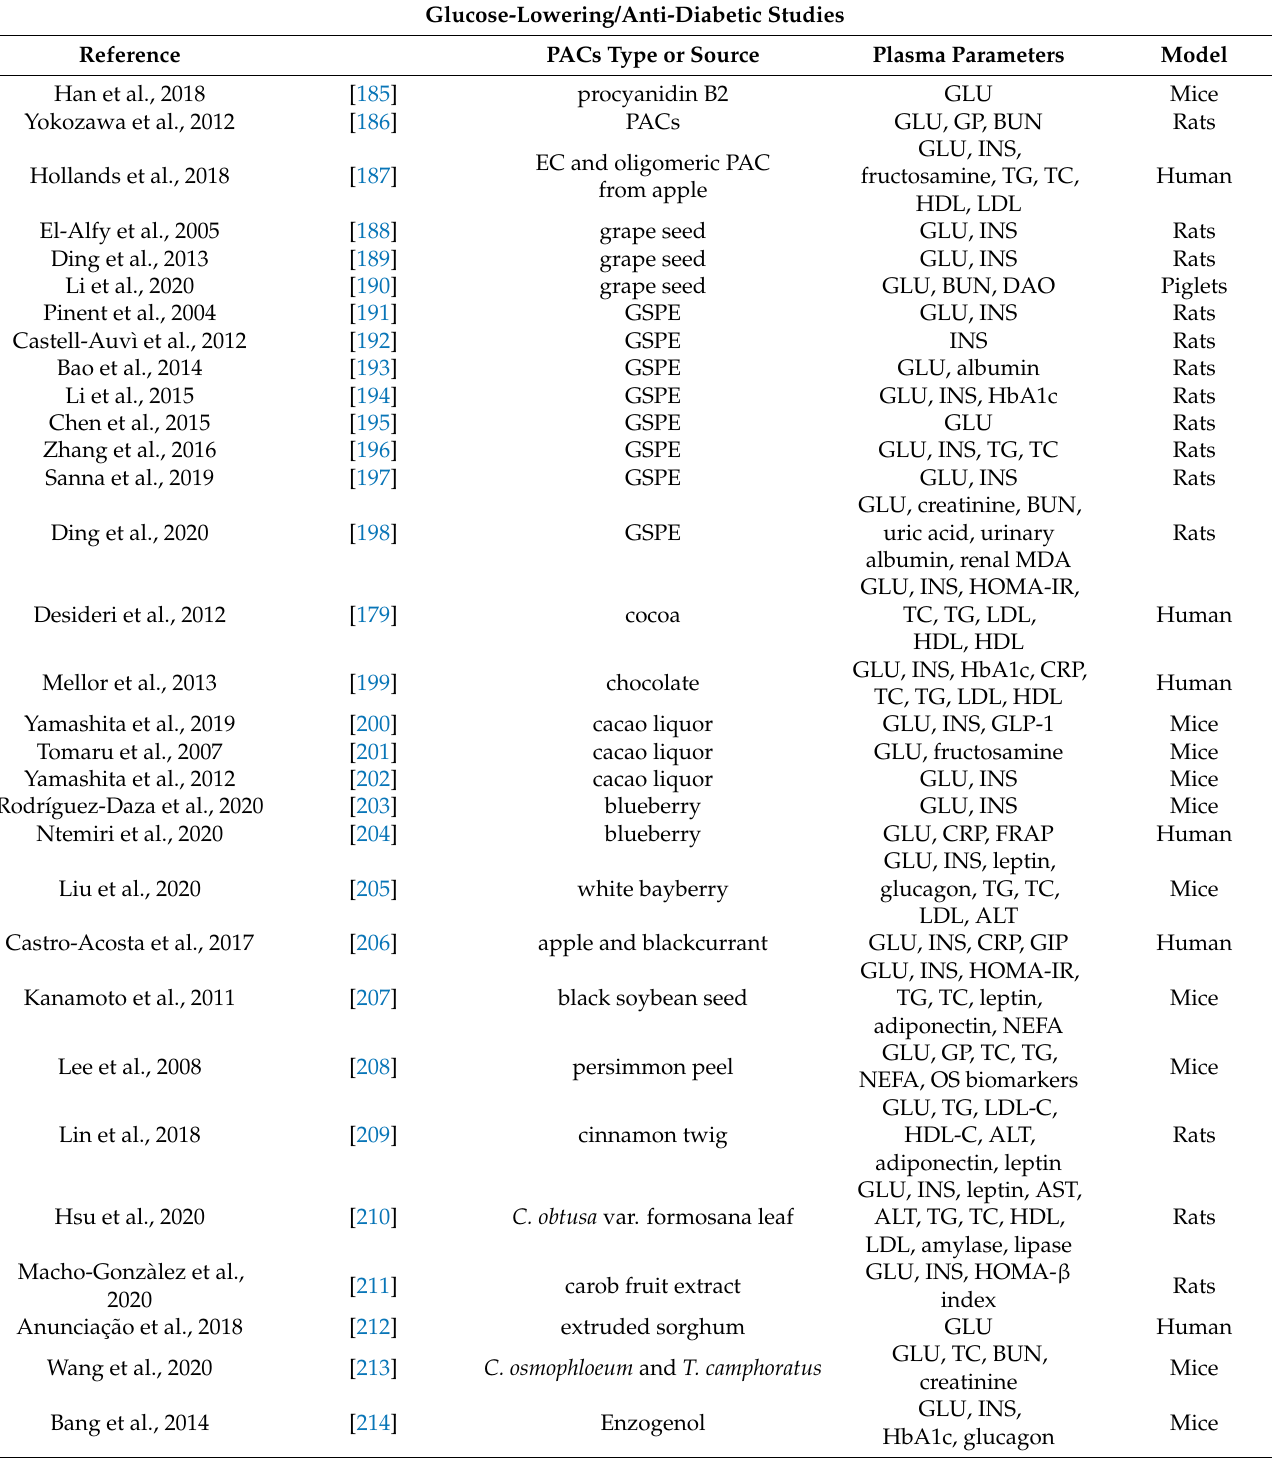
Table 2. In vitro and in vivo studies on PAC-mediated glucose-lowering